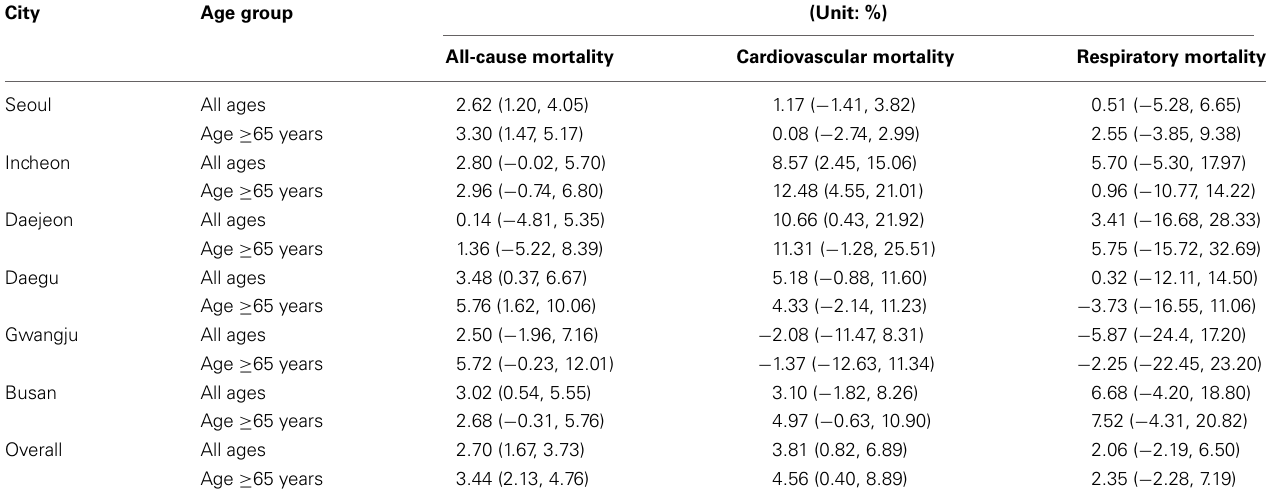
Table 2 | Percent change in mortality risk for 1 ◦ C increase in daily mean